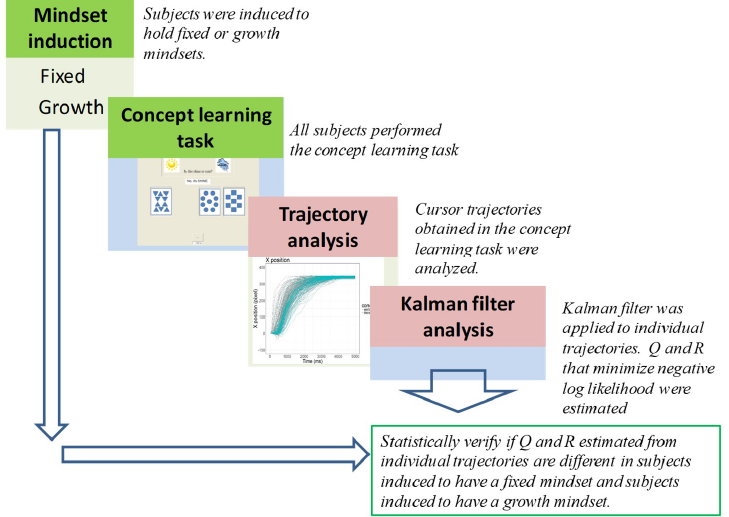
Figure 3. A flow diagram illustrating the time course of the experiment and data analysis.